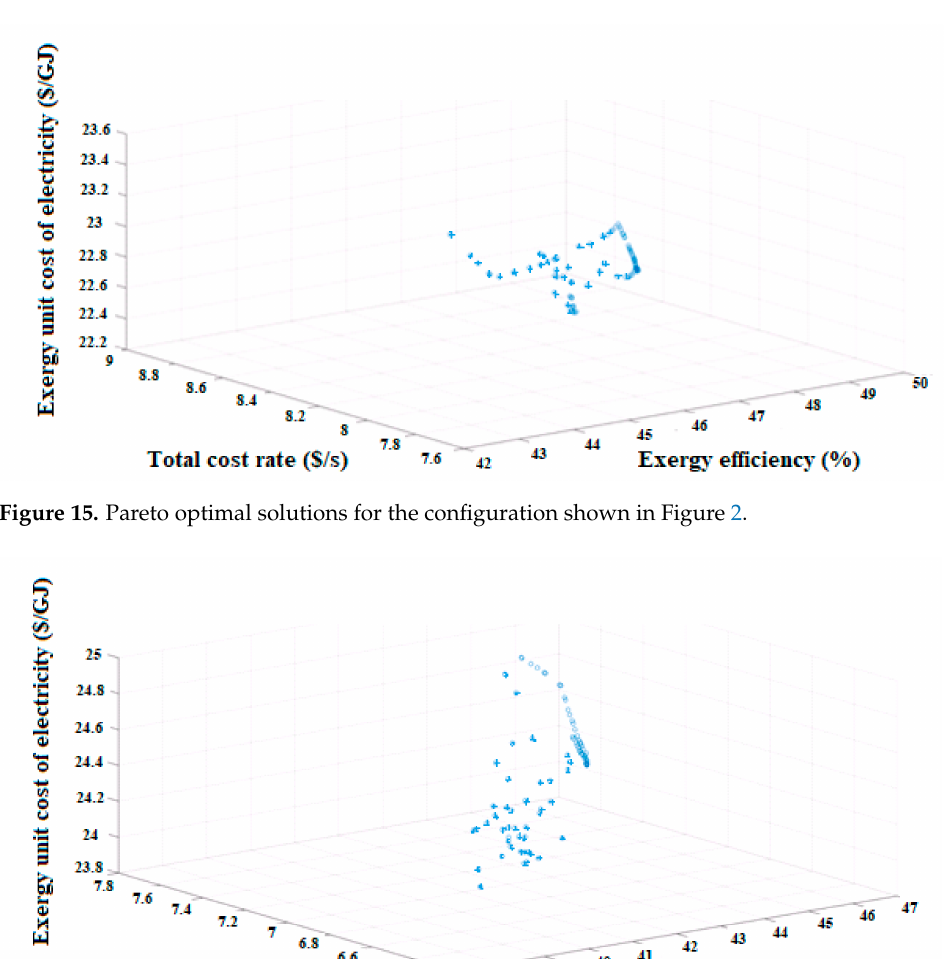
Figure 14. Pareto optimal solutions for the configuration shown in Figure 1.